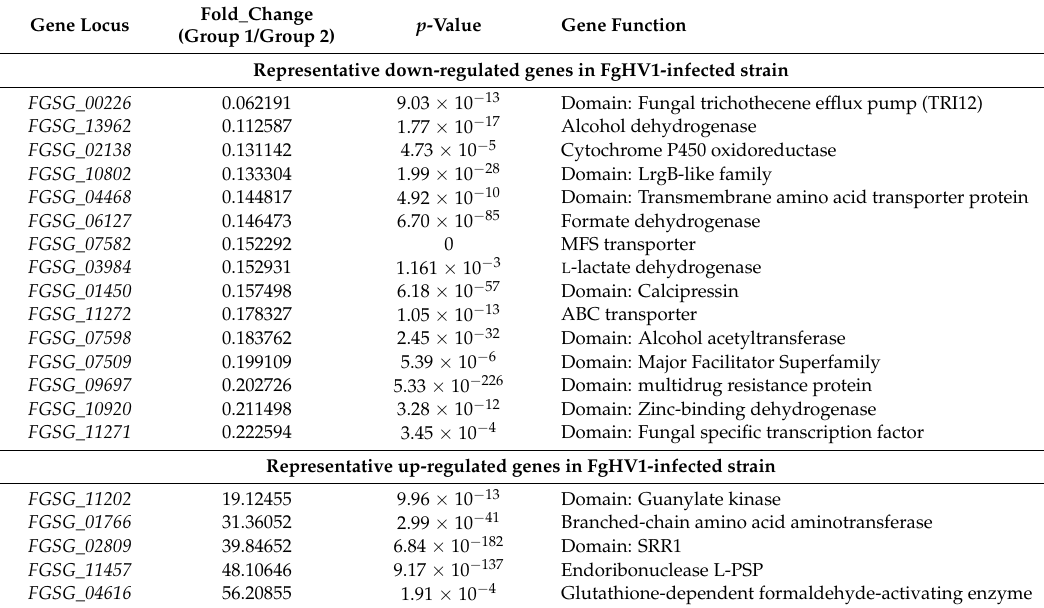
Table 2. Representative down-regulated and up-regulated F. graminearum genes showing relatively higher fold-changes in the FgHV1-infected strain relative to the virus-free strain. Gene Locus p